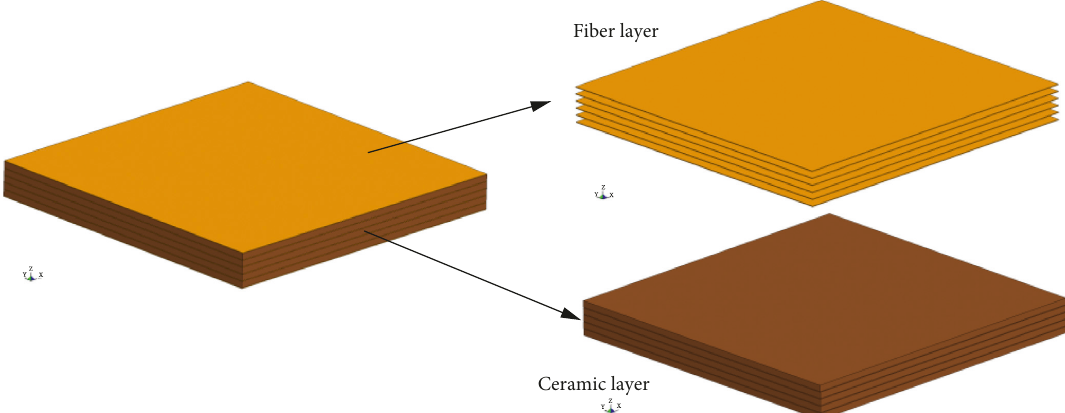
Figure 8: Combined model of the FC target.